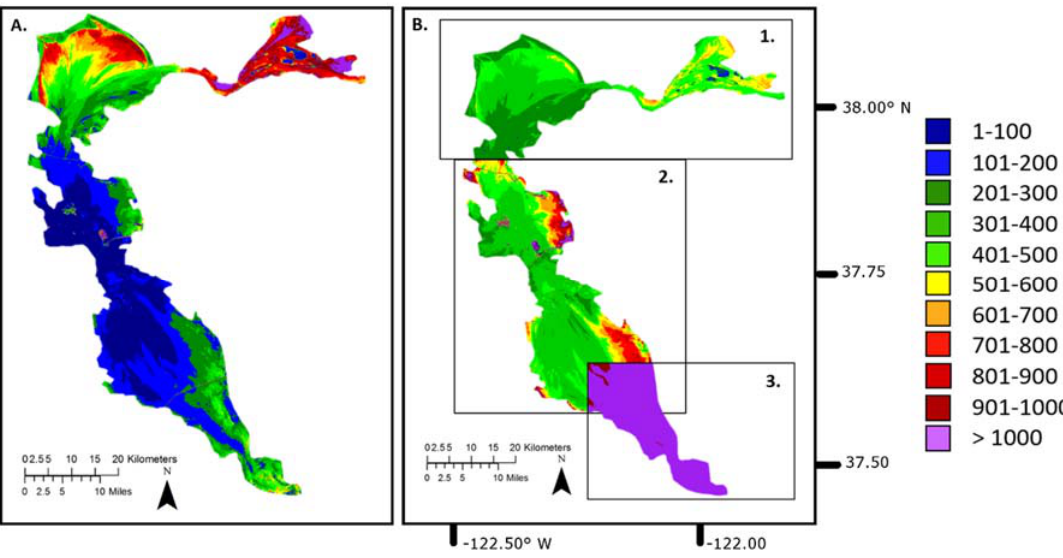
Figure 4. PCB concentration maps (pg/L) generated using SSC to PCB relationship generated for the entire SFB ( A ) and localized to the three sub-embayments ( B ) (see Figure 1). ( A ) Entire bay [PCBs = 8.84(SSC)]. To correct for the observation that PCBs tightly coupled with sediments and are not otherwise detectable in the water column, the y-intercept was forced through zero for 4A (y = 8.84x). ( B ) 1. Northern Bay [PCBs = 3.47(SSC) + 150]. ( B ) 2. South-Central Bay [PCBs = 20.89(SSC) + 153]. ( B ) 3. Southern Bay [PCBs = 11.05(SSC) + 878]. Satellite imagery was taken on 26 May 2016 by L8 OLI and corrected using OLI’s terrestrial-based algorithm. Concentration maps were created in ENVI (Harris Geospatial Solutions, Boulder, CO, USA) using the respective relationships between PCBs, SSC, and reflectance previously reported in Tables 1 and 2. All relationships are highly significantly different as tested by ANCOVA.